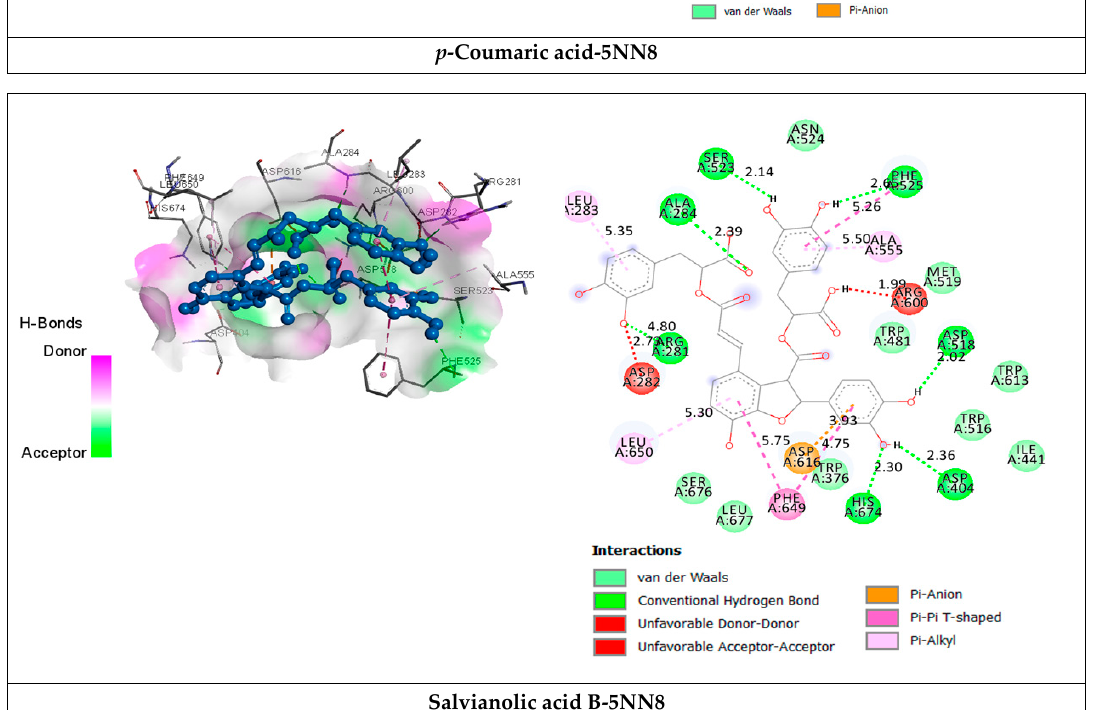
Figure 3. Interactions of human lysosomal acid- α -glucosidase (PDB: 5NN8 ) with the selected major phytochemicals, with the top two having the lowest binding energies of E. humile Desf. methanolic extract.